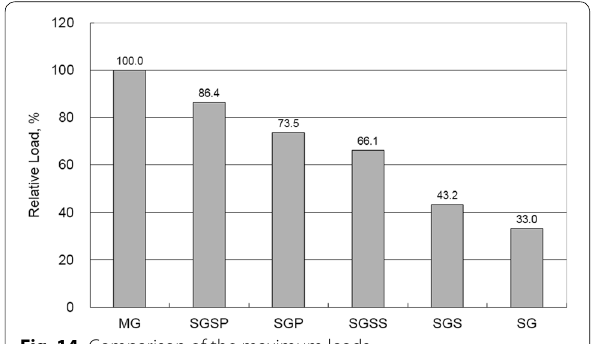
Fig. 14 Comparison of the maximum